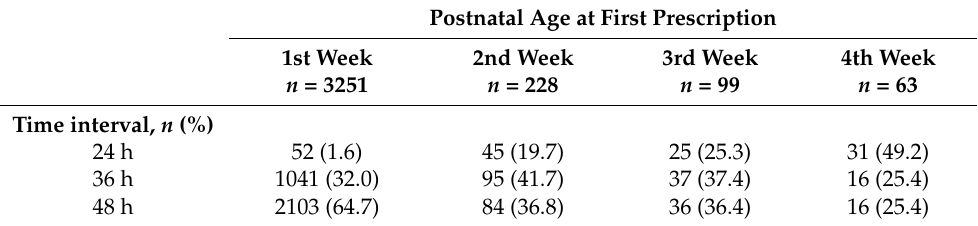
Table 4. Distribution of time intervals between gentamicin doses in 3641 very preterm infants (27–31 weeks) according to postnatal age at first